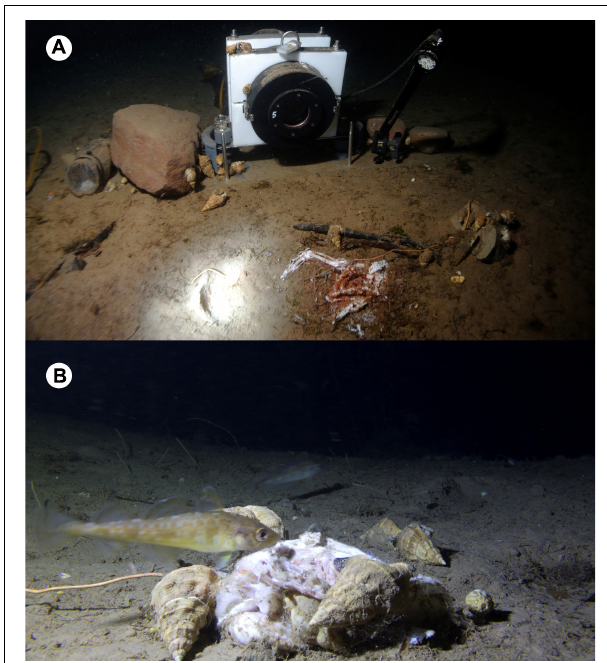
FIGURE 2 | Time-lapse camera system, equipped with baited trap (on the left), in front of the bird bait (A) , and a sample photographic image produced by the system (B) .